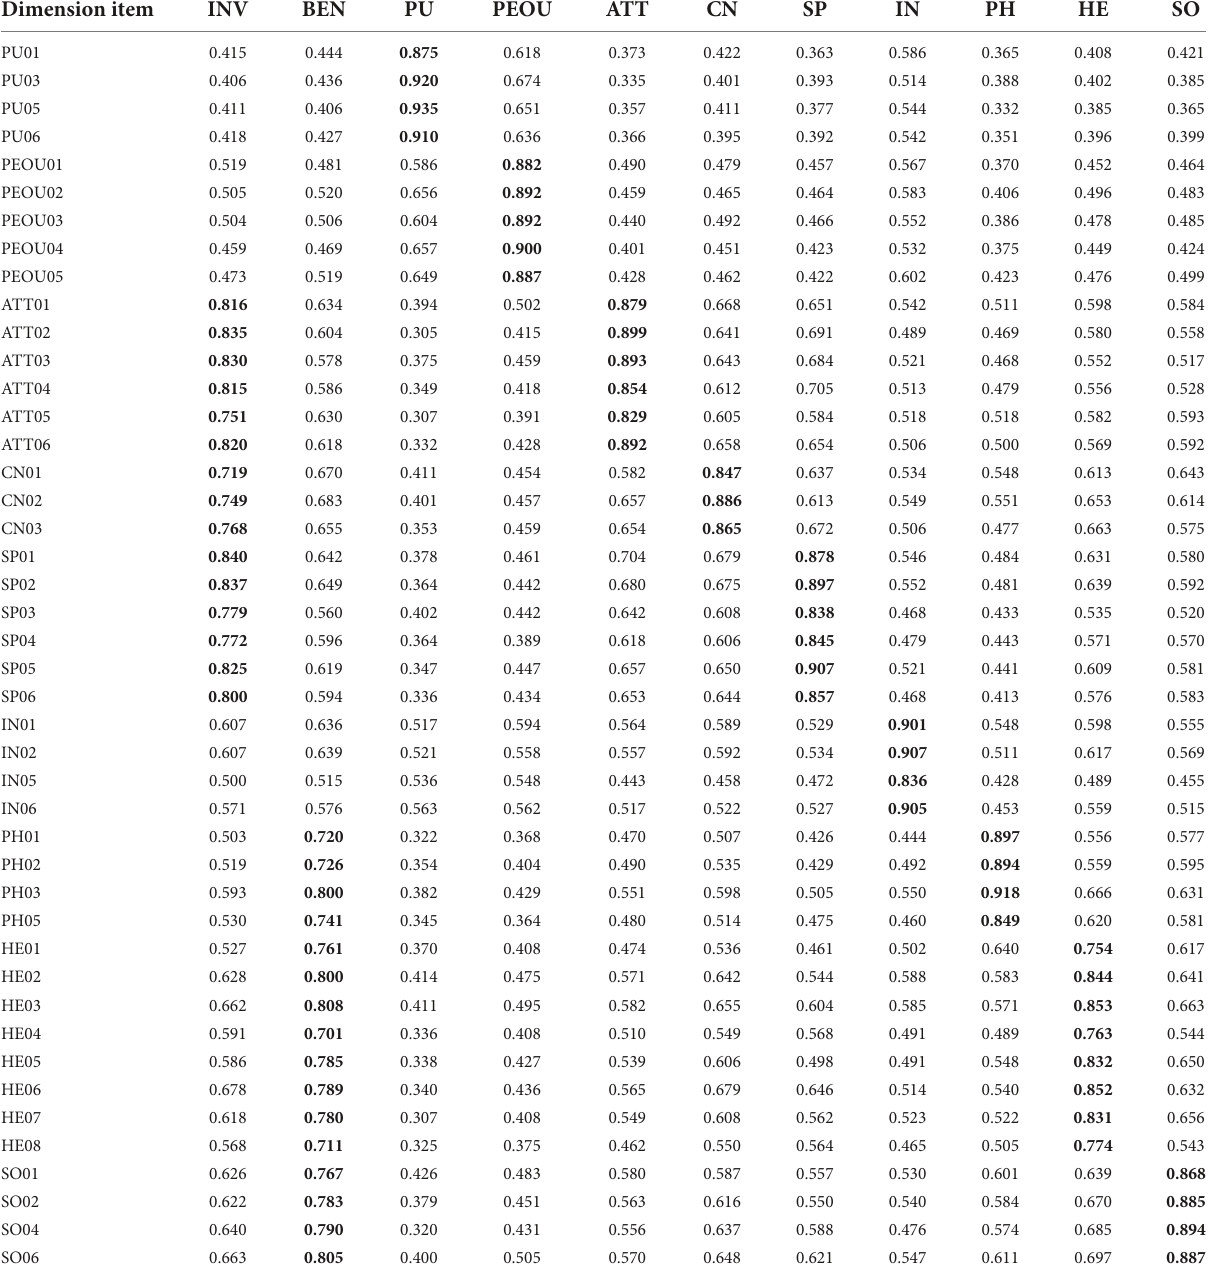
TABLE 3 Cross-loadings of all dimensions in